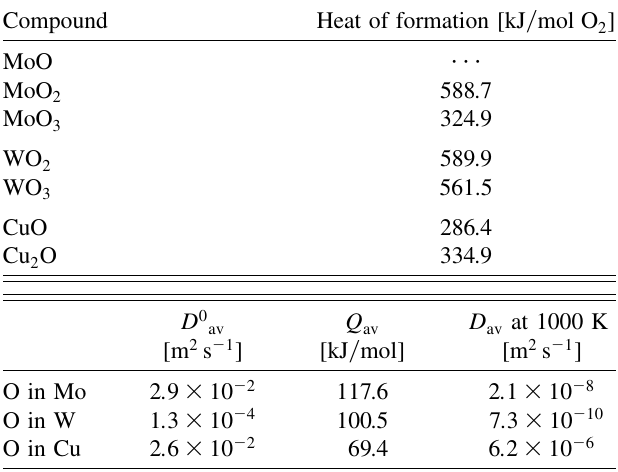
TABLE II. (Top) Heat of formation of some oxide compounds of Mo, W, and Cu. (Bottom) Average values for diffusion ), activation energy ( Q ) and diffusion at coefficient ( D 0 av av 1000 K for oxygen atoms through bulk molybdenum, tungsten, and